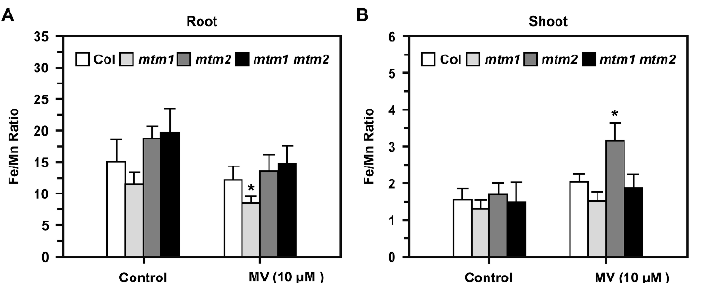
Figure 8. Fe/Mn ratios in roots and shoots of Col, mtm1 , mtm2 , and mtm1 mtm2 -double mutants in response to MV. ( A , B ) Fourteen-day-old seedlings were incubated with 10 μM MV for 3 days. Fe and Mn contents in roots and shoots were measured by ICP-OES, and converted to Fe/Mn ratio. Data are mean ± SD of three independent repeats. * Significant at p < 0.05 compared with the